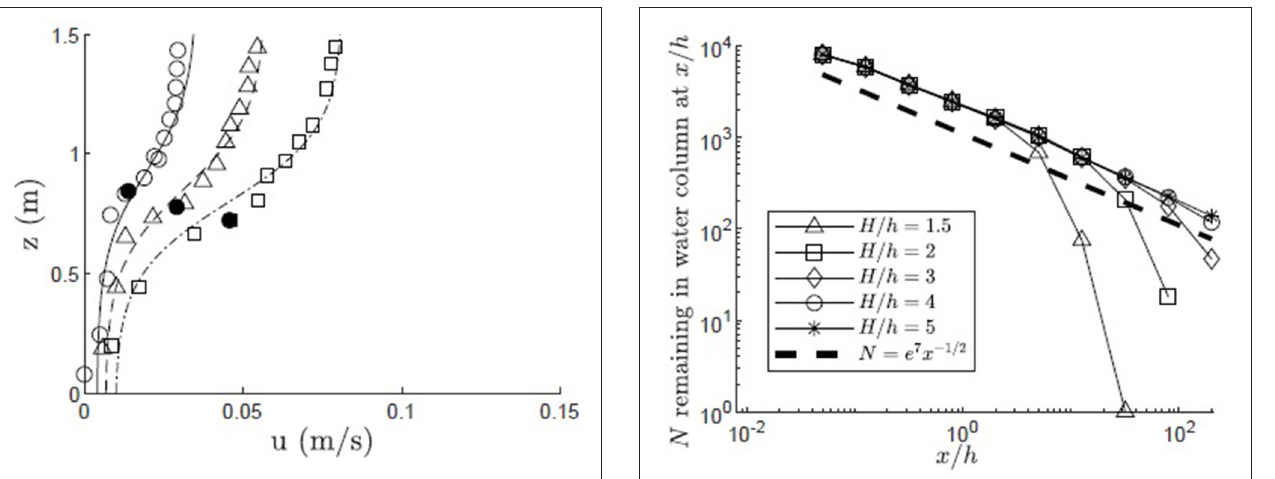
particles toward the canopy, which in turn depends on the vertical gradient of particle concentration, ∂ C /∂ z , above the ∂ C /∂ z . The remaining particles, N , are canopy, i.e., ∂ N /∂ x ∼ distributed above the canopy over the vertical length-scale for diffusion, δ z x − 1 / 2 , such that the mean concentration above ∼ the canopy is C mean N /δ z . Since the concentration is close to ∼ zero in the canopy, ∂ C /∂ z C mean /δ z N /δ 2 Nx − 1 . Since z ∼ ∼ ∼ ∂ N /∂ x ∂ C /∂ z , we can also write ∂ N /∂ x Nx − 1 , which has ∼ ∼ the solution N x − 1 / 2 ∼